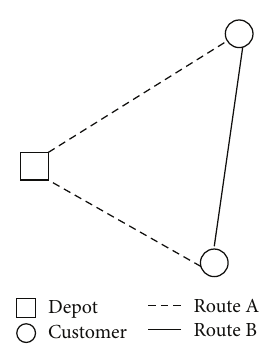
Figure 6: Two types of VRPU